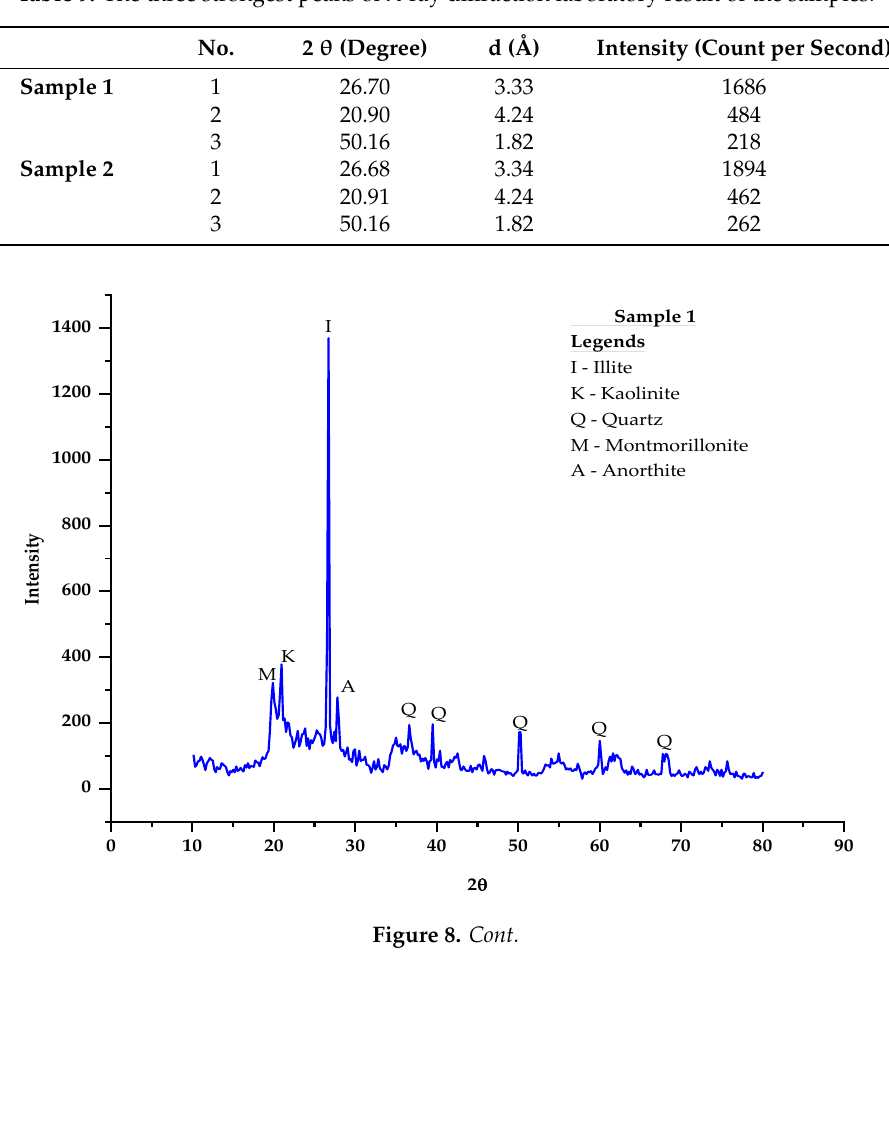
Table 9. The three strongest peaks of X-ray diffraction laboratory result of the samples.